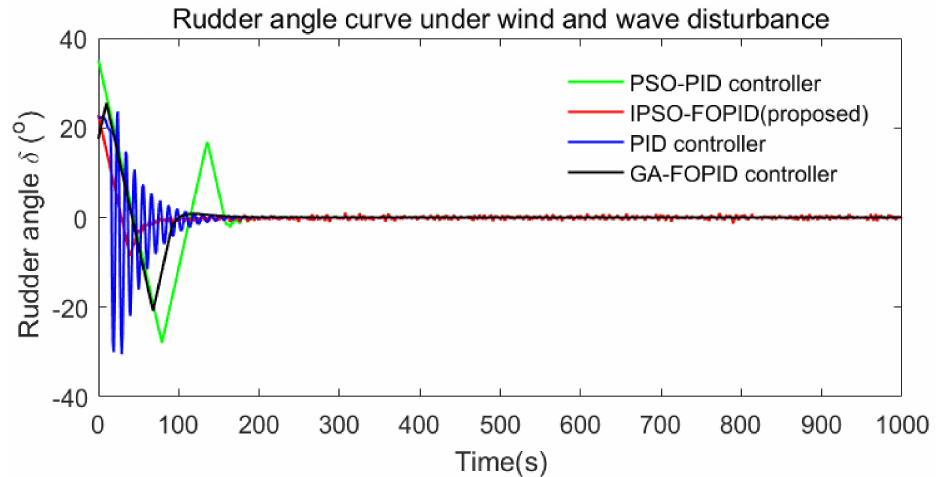
Figure 18. Rudder angle curves under wind and wave